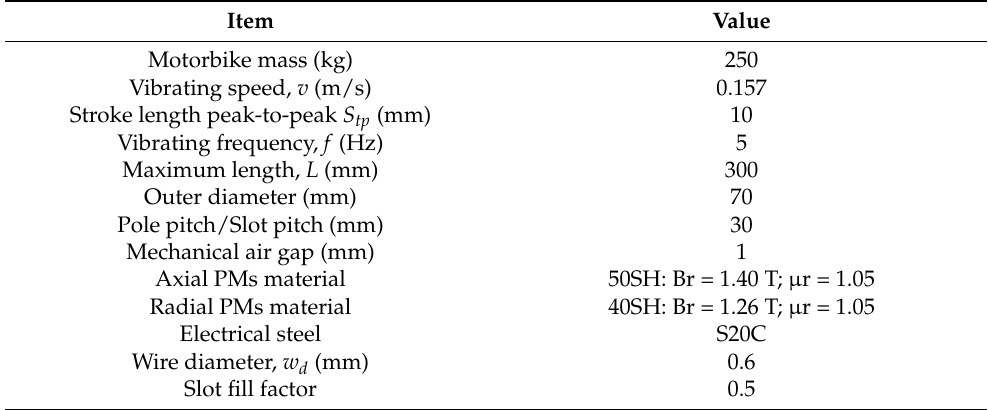
Table 1. Design specifications.